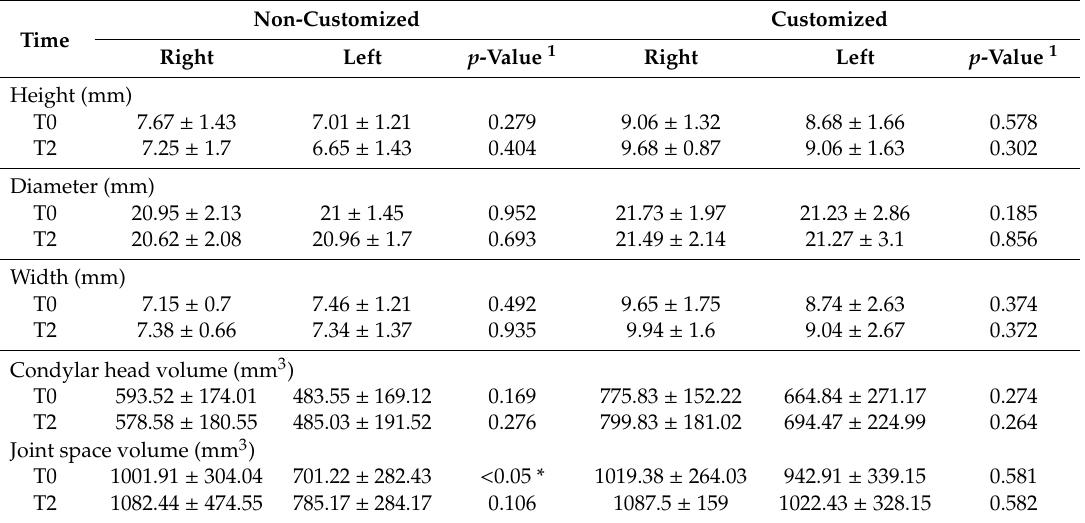
Table 4. Mean values of right and left condylar morphology at T0 and T2 for each